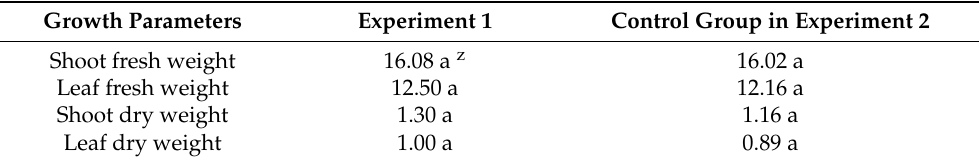
Table 3. Shoot and leaf fresh weights and shoot and leaf dry weights of basil plants in Experiment 1 and the control group (1T under RB7:3) in Experiment